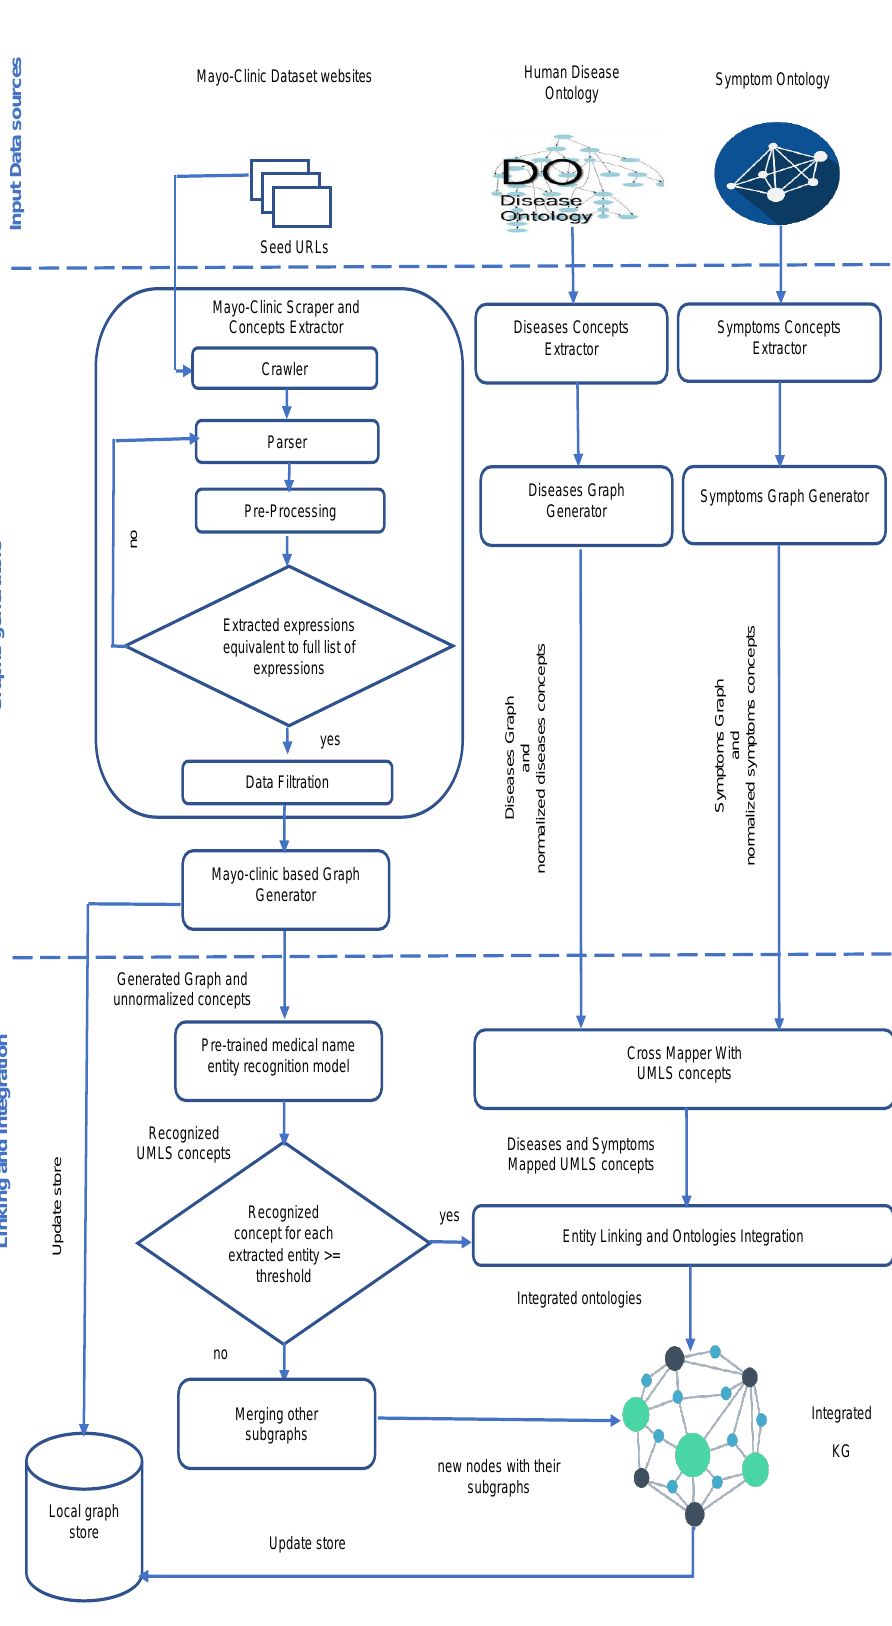
Figure 2. Framework for generating standardized-based integrated medical knowledge